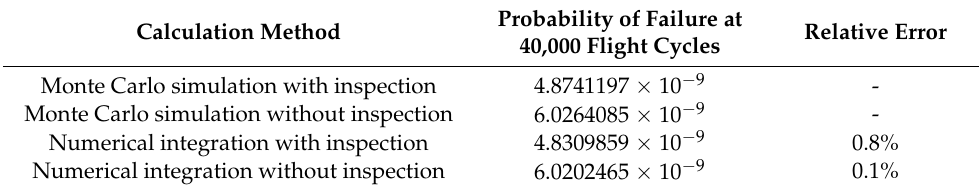
Figure 13. Comparison of the probability of failure of different methods. Table 3. Probability of failure at 40,000 flight cycles for different